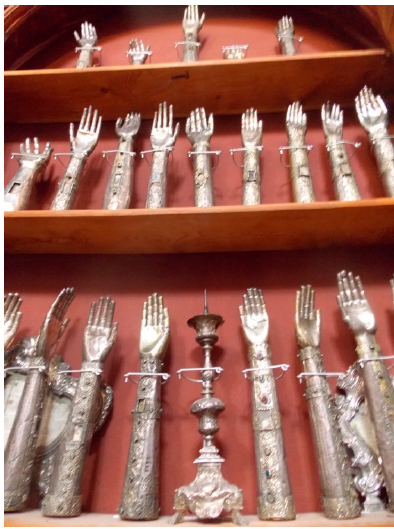
Figure 2. Reliquaries, 16th–18th century, Kotor, Saint Tryphon’s relic chapel (photo by author).